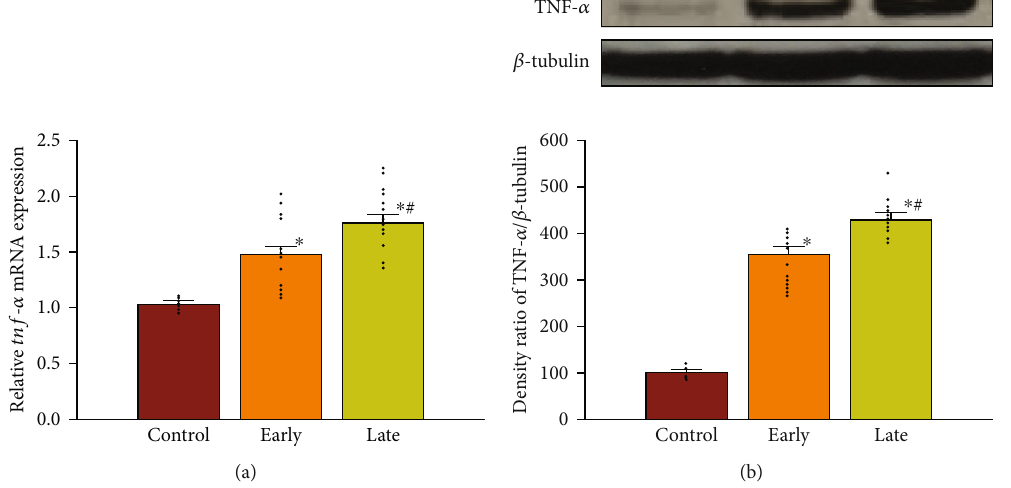
Figure 3: Prenatal opioid exposure enhanced the TNF- α expression in the ventral-medial striatum of neonatal rat o ff spring on P14. (a) The expression of TNF- α at mRNA level in the ventral-medial striatum of neonatal rat o ff spring from morphine-addicted mothers. (b) The expression of TNF- α at protein level in the ventral-medial striatum of neonatal rat o ff spring from morphine-addicted mothers. The groups were as follows: the control group ( n = 12 rats), the early group ( n = 12 rats), and the late group ( n = 12 rats). The upper panel indicates representative immunoblots. β -Tubulin served as an internal standard control and was not signi fi cantly changed across lanes. Scatted dots represent the data points in each group. ∗ p < 0 : 05 , compared to the control group. # p < 0.05, compared to the early